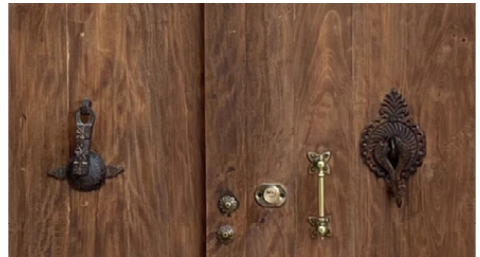
Fig 1: Kubeh—traditional gendered door knockers